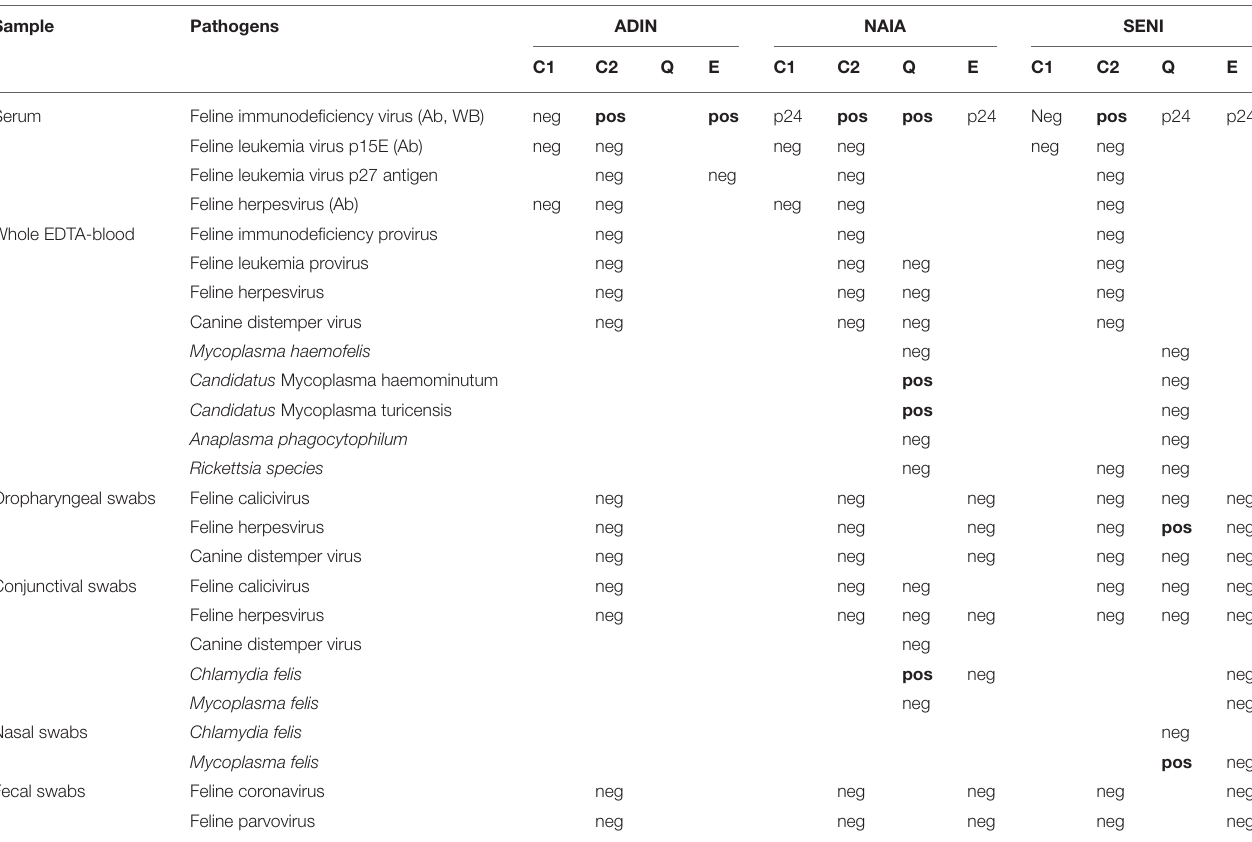
TABLE 3 | Pathogen screening at different time points of the three Eurasian lynx ( Lynx lynx ) seropositive for feline immunodeficiency virus by Western blot: 1st field capture (C1), 2nd field capture (C2), during quarantine (Q), and before euthanasia (E).